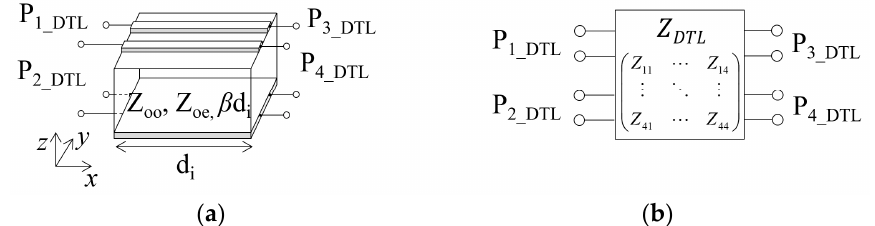
Figure 3. ( a ) Coupled line and ( b ) impedance parameter expression for a segment of CGP-EBG MTM-DTLs.